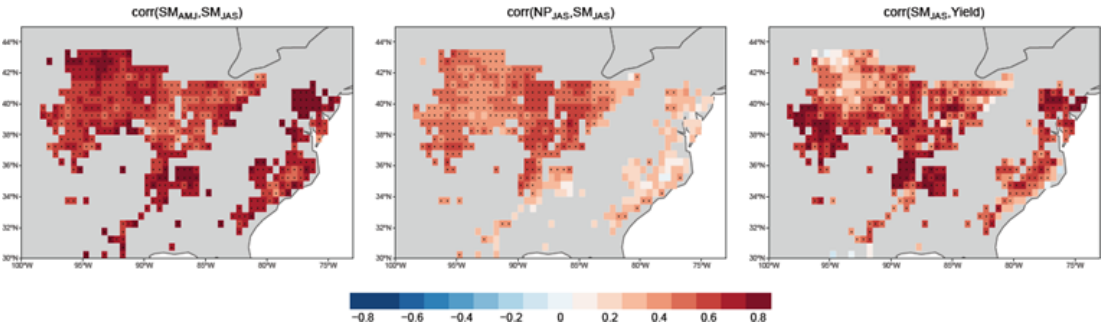
Figure A4. Grid-based correlation maps for crop yields, the NP pattern and antecedent (boreal spring – AMJ) soil moisture against summer soil moisture (boreal summer –